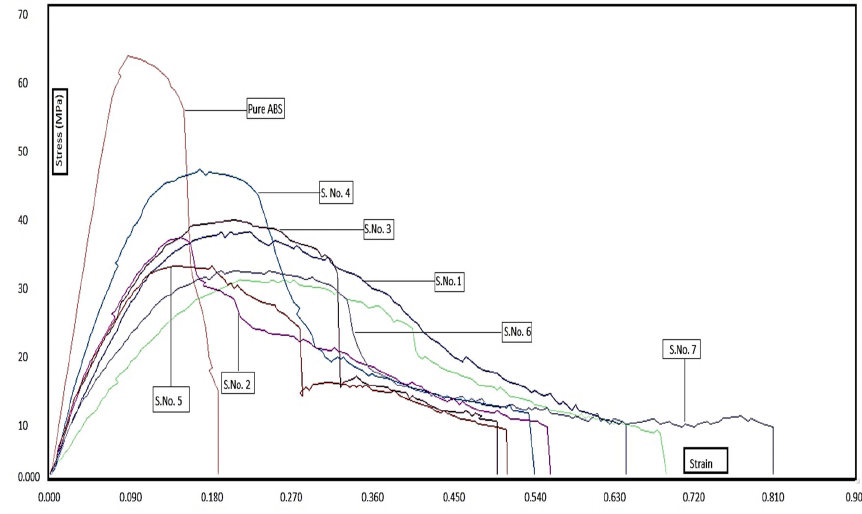
Figure 9. Two-dimensional contour plots for ( a ) break elongation and ( b ) flexural strength of ATA and TAT samples.